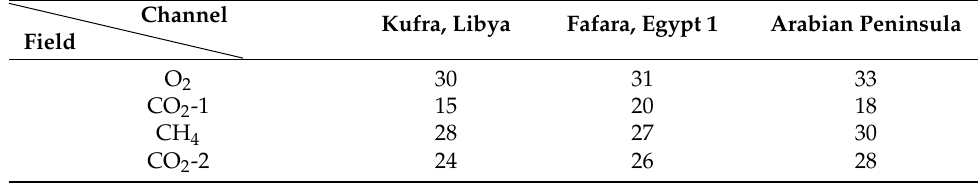
Table 6. Calibration data of the GMI.